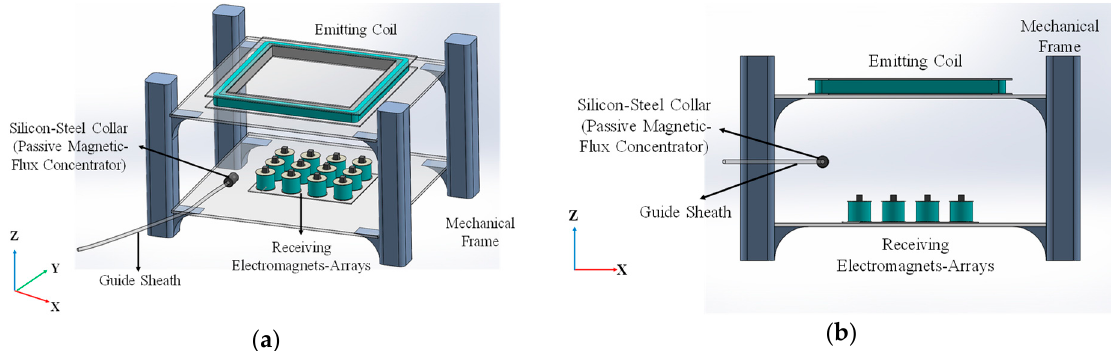
Sensors 2019 , 19 , x FOR PEER REVIEW